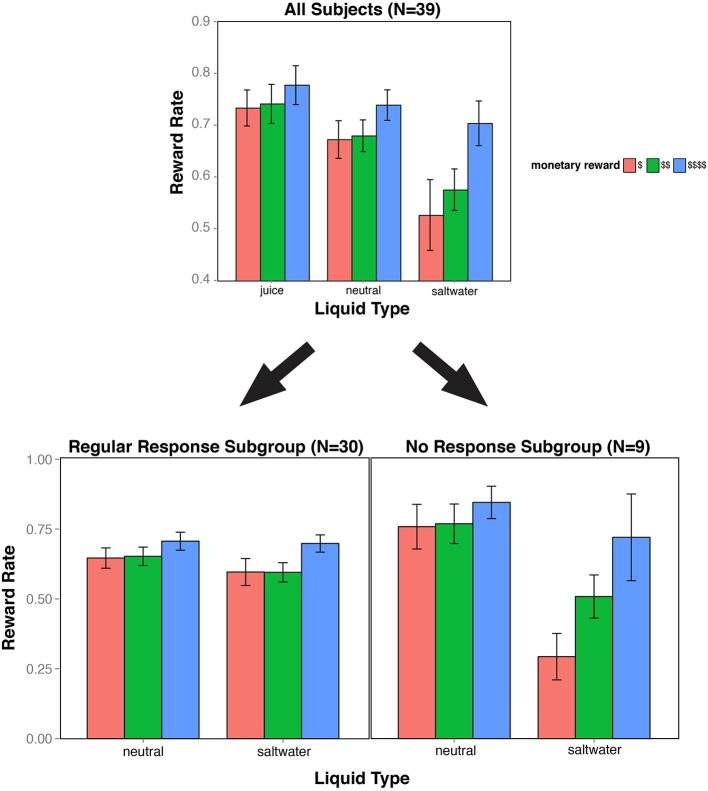
Reward rate bar plot. The bar plot indicates reward rate performance as a function of experimental condition (three levels of monetary reward, and three types of liquid feedback). The top figure includes all 39 subjects in the analysis. This figure highlights the significant main effects of monetary reward, liquid valence, and the interaction of the two factors when contrasting neutral and saltwater conditions. The data were further divided into two subgroups. In the No Response subgroup (below right), the interaction pattern was even more strongly present, while in the Regular Response subgroup (below left), the interaction was absent, though there was still a (trend-level) effect of saltwater on reward rate.